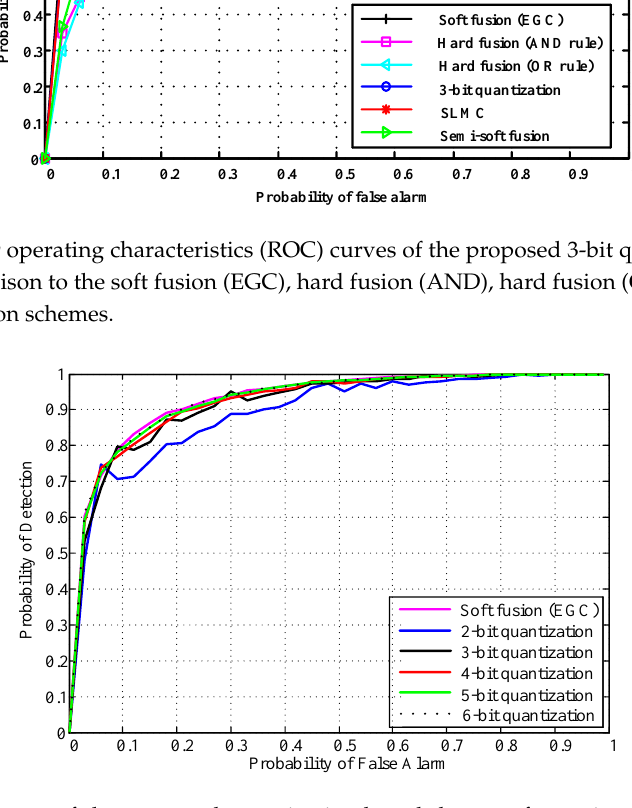
Figure 5. ROC curves of the proposed quantization-based detector for various quantization bits ( N = 400, M = 6, SNR = −12 dB).